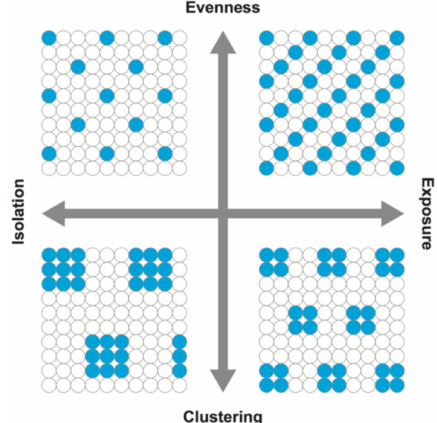
Figure 5. The Dimensions of Segregation